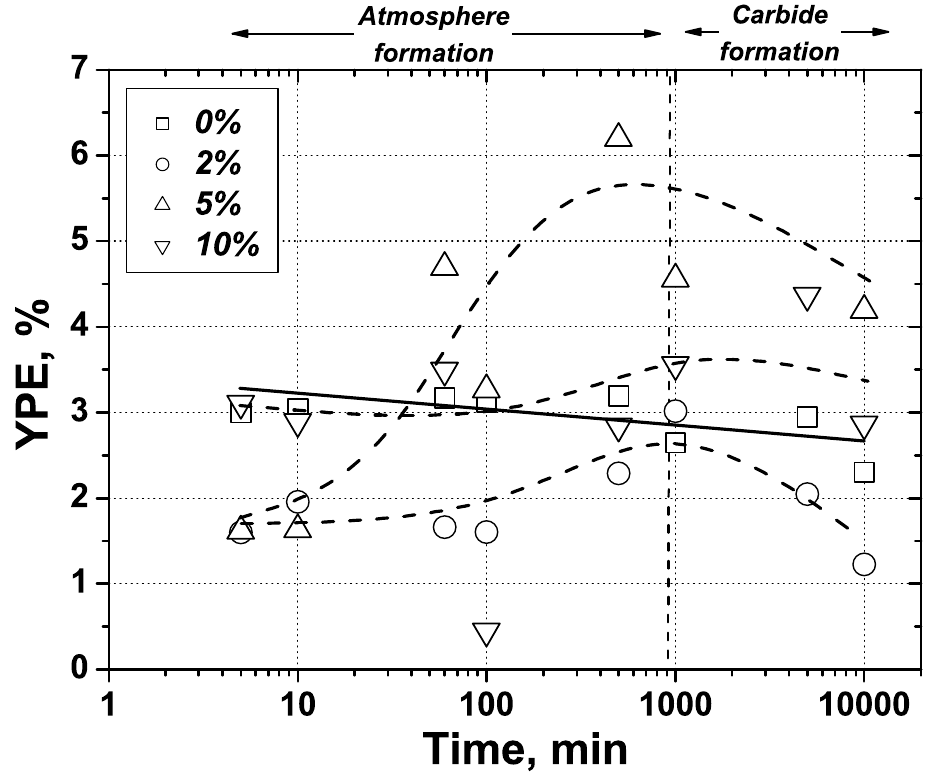
Figure 9. Yield point elongation as function of the aging time for aging at 170 ◦ C from 5 to 10,000 min for 0%, 2%, 5%, and 5% prestrain for the TRIP3 steel.